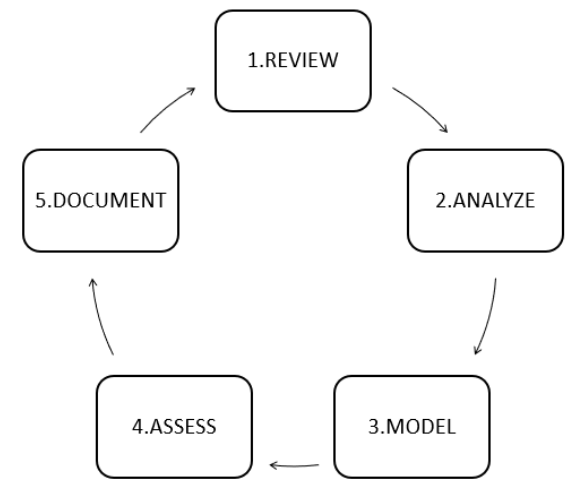
Figure 1. RAMAD methodology